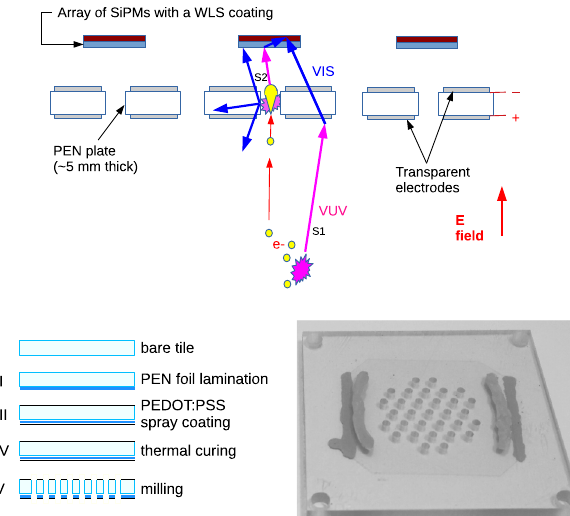
Fig. 1 (Top) Cross-sectional scheme illustrating the operation of the new WLS-transparent amplification structure, showing photon tracks from S1 and S2 emissions, with VUV in magenta and visible in blue. (Bottom-left) Steps of the fabrication sequence for structure ‘e’. (Bottom-right) Fabricated structure ‘e’, with deposited silver-based epoxy contacts